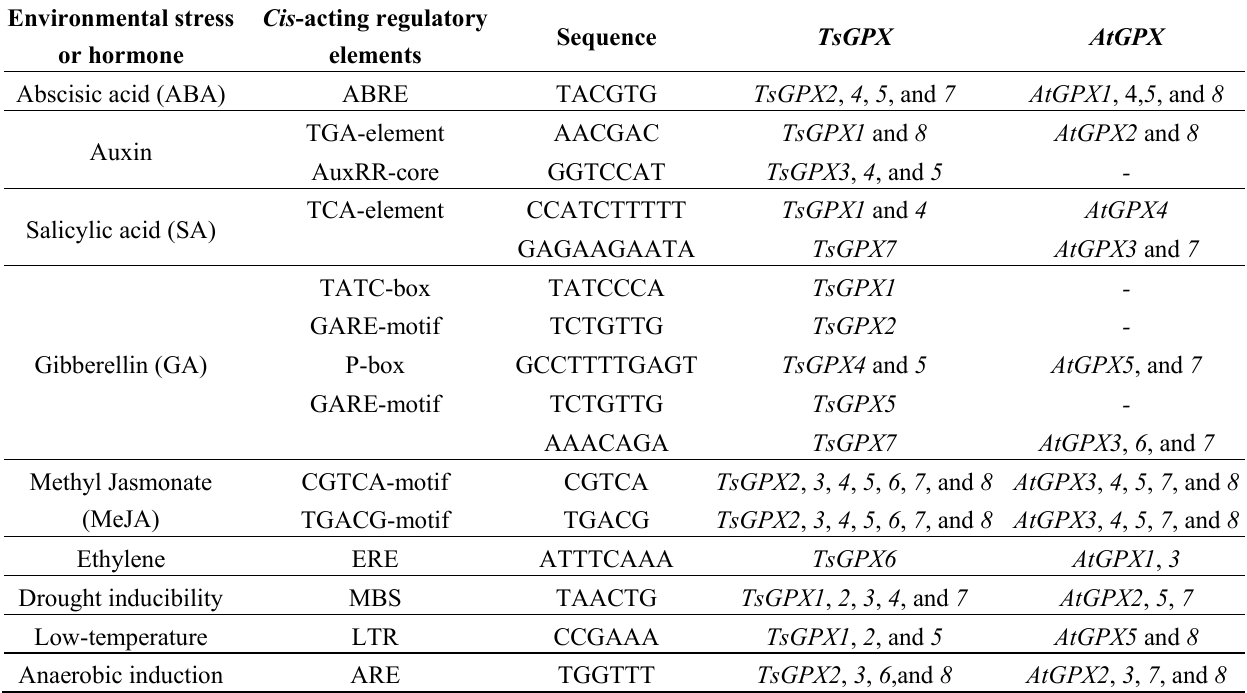
Table 2. Putative cis -acting regulatory elements related to stress and hormone response in TsGPX and AtGPX